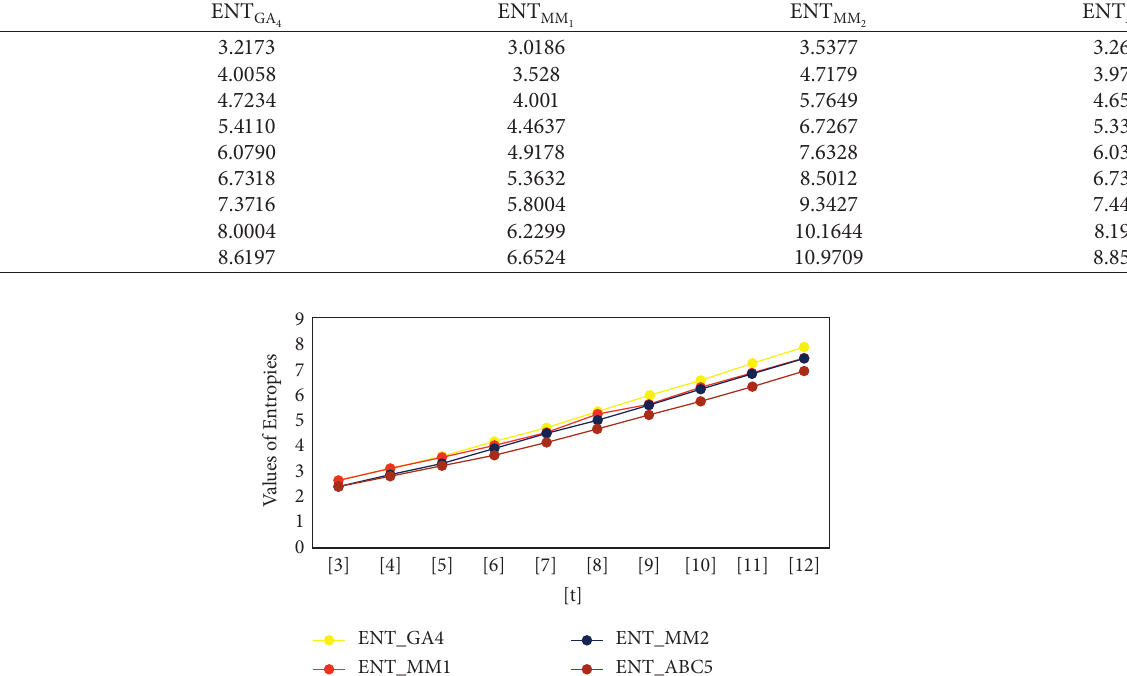
GA 4 , ENT MM 1 , ENT MM 2 , and ENT ABC 5 for